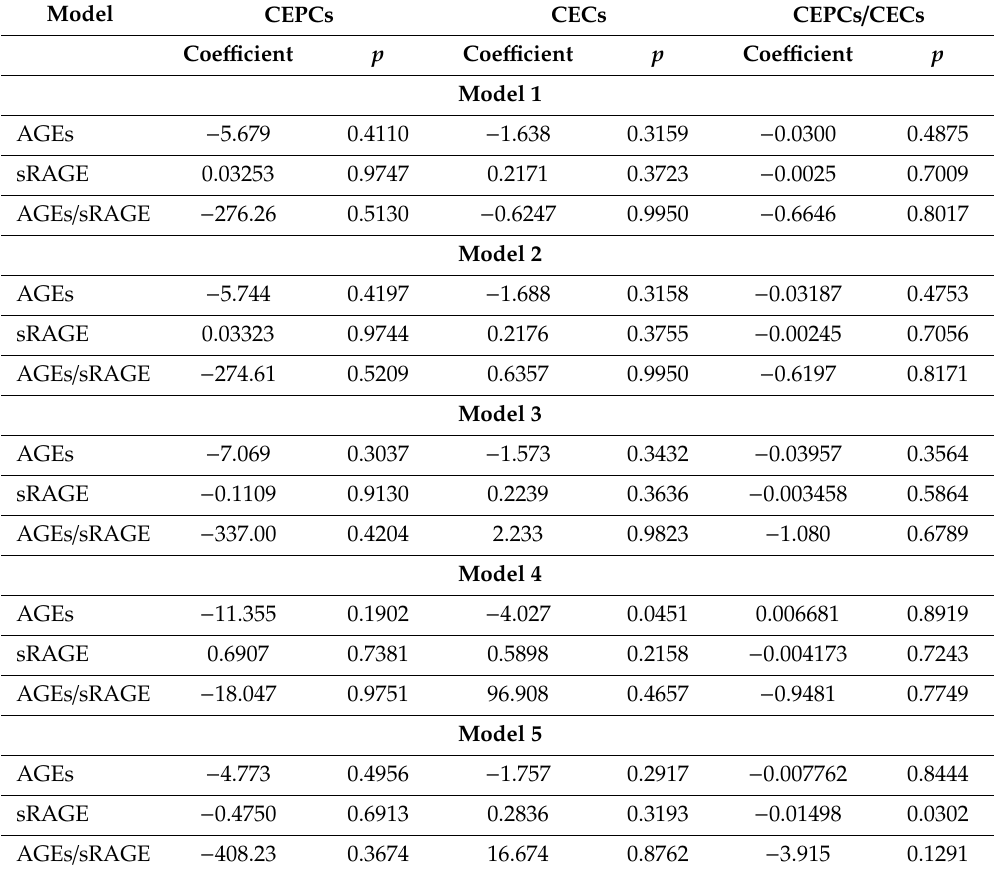
Table 6. Multivariate analysis of relation between endothelium dysfunction and AGEs, sRAGE, and AGEs / sRAGE